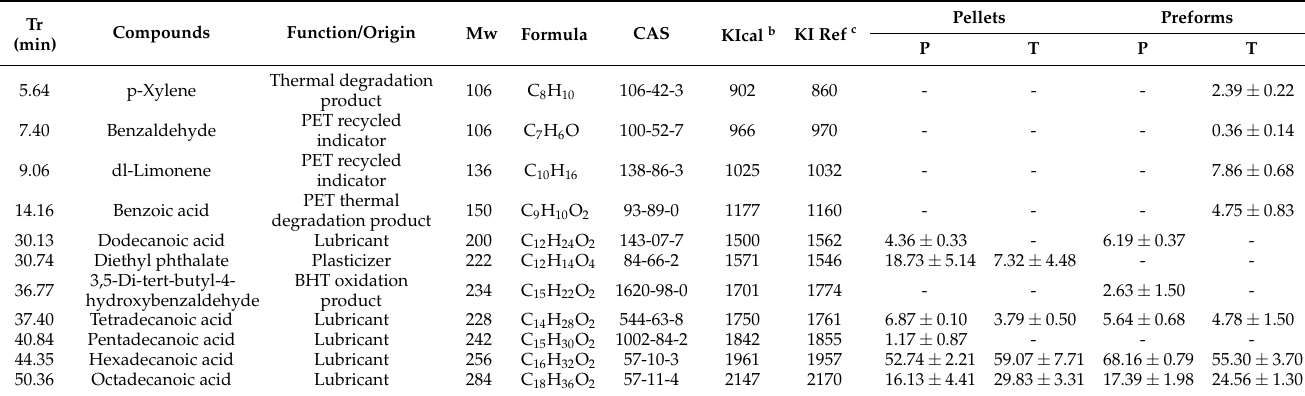
Table 1. GC-MS peak relative area a of compounds identified in PET pellets and preforms P and